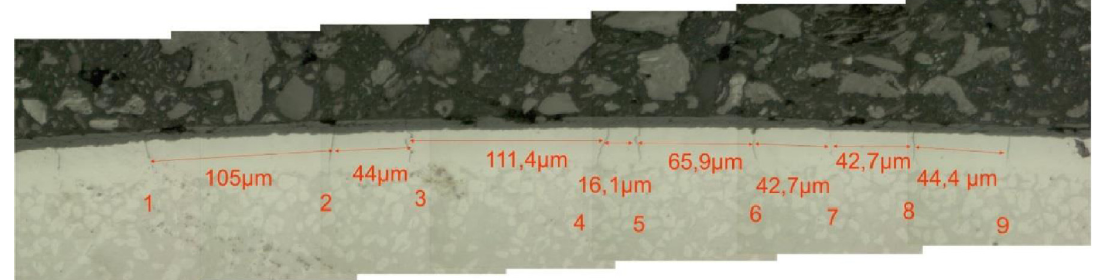
Fig. 3. Crack nucleation and crack spacing at outer diameter equatorial location of CCT3 interrupted CCT test at 92% of the failure load (comparison to CCT1 test twining